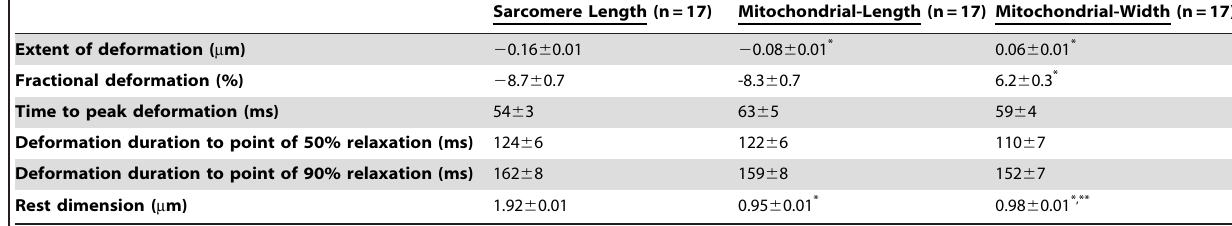
Table 1. Sarcomere and mitochondria deformation